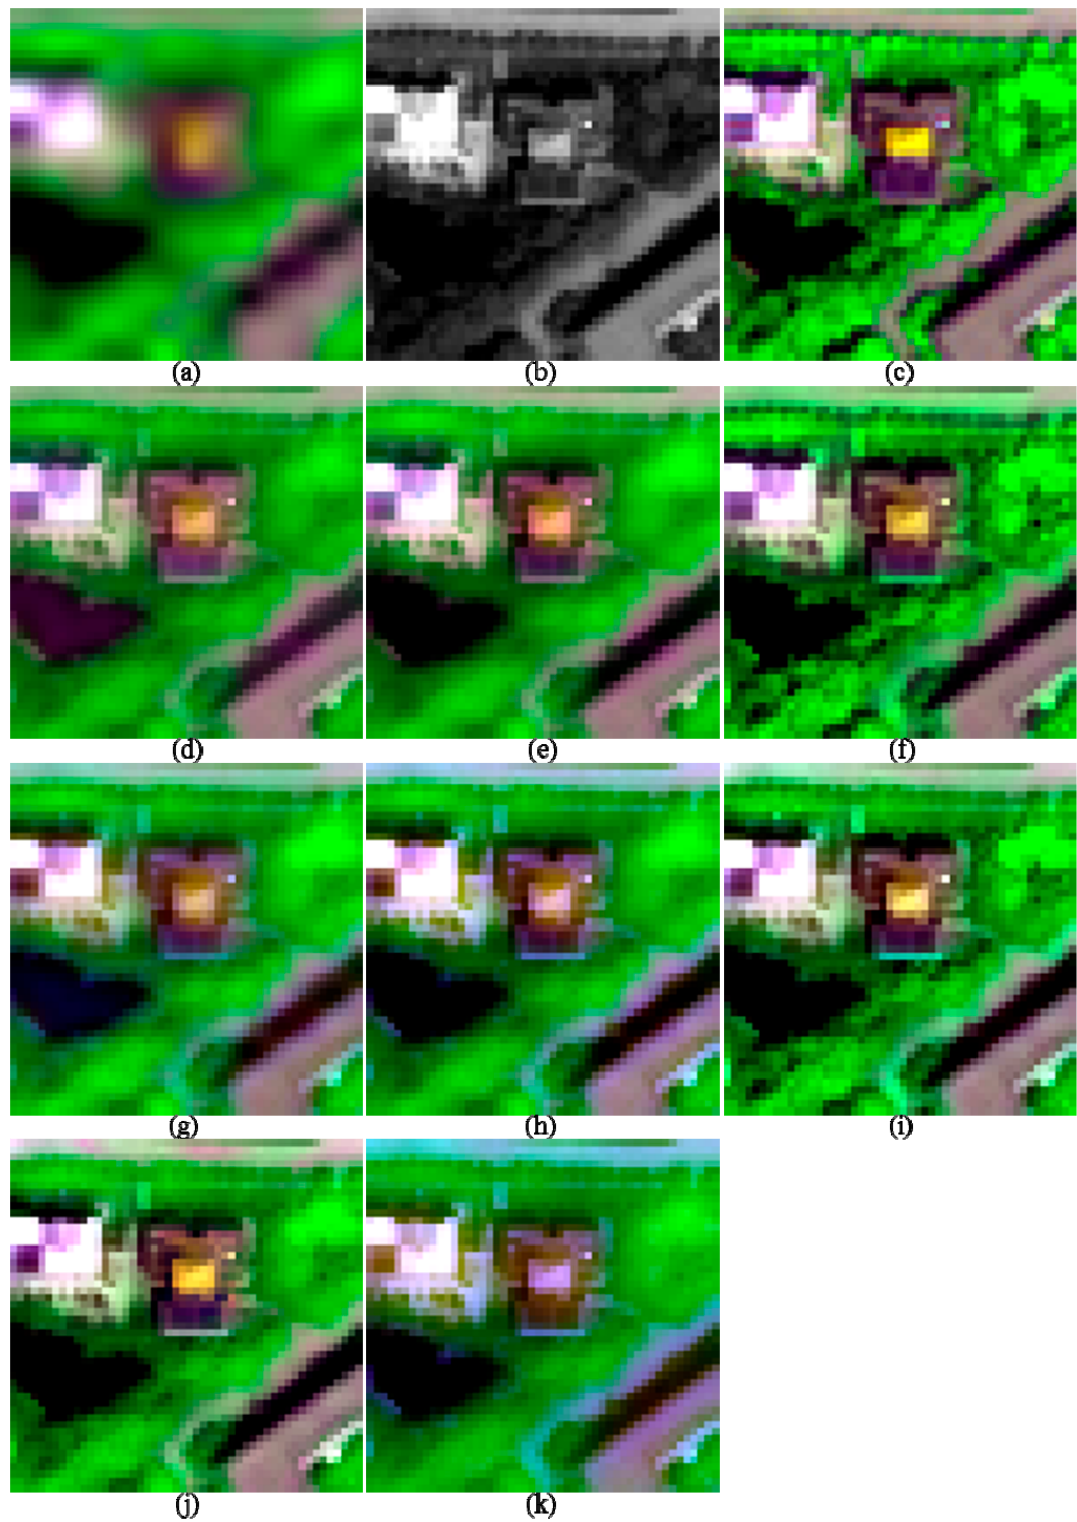
Figure 5. The original and 2-m fused images of I3, shown in band 5-7-2 composition. ( a ) 8-m MS; ( b ) 2-m PAN; ( c ) True 2-m MS; ( d ) GS; ( e ) GSA; ( f ) HR; ( g ) HCS; ( h ) ATWT; ( i ) GLP_ESDM; ( j ) GLP_ECBD; and ( k ) NSCT_M2.